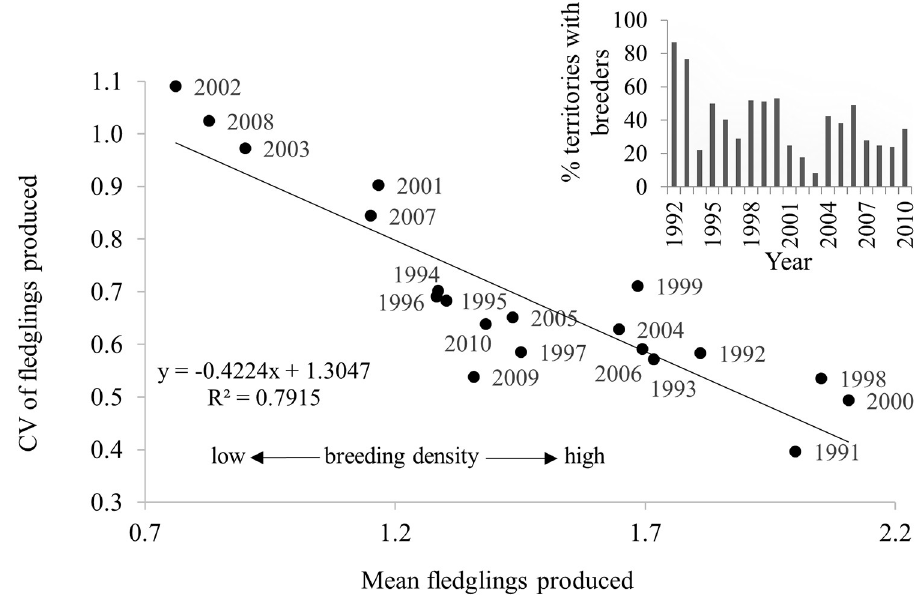
Fig 18. Variation in annual fledgling production and goshawk breeding density contradicts the ideal pre-emptive model. Contrary to predictions from the ideal pre-emptive model of habitat selection wherein the annual coefficient of variation (CV) in annual fecundity increases with breeder density as more lower quality territories become occupied and produce fewer and fewer young, the CV of annual fledgling production declined as breeding density increased (percent of territories with breeders; see inset) increased in Arizona,